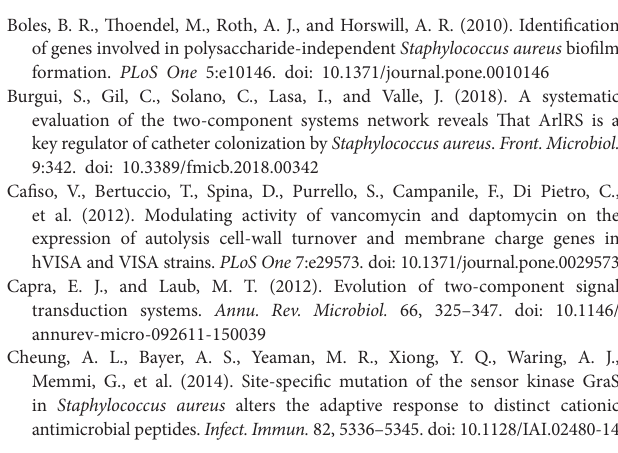
SUPPLEMENTARY FIGURE S1 | WGCNA analysis and the mRNA levels of interested genes in GSE26016. (A) Clustering dendrogram of genes in GSE26016. (B) Clustering tree based on the module eigengenes of modules. (C) Network heatmap plot in the co-expression modules. (D) The mRNA levels of hla , hlb , and coa in GSE26016. (E) The mRNA levels of mprF , dltX , dltA , and agrA in GSE26016. WGCNA: weighted gene co-expression network analysis. SUPPLEMENTARY FIGURE S2 | The effect of graRS knockout on the mRNA levels of the CAMP resistance-associated genes. The mRNA of the